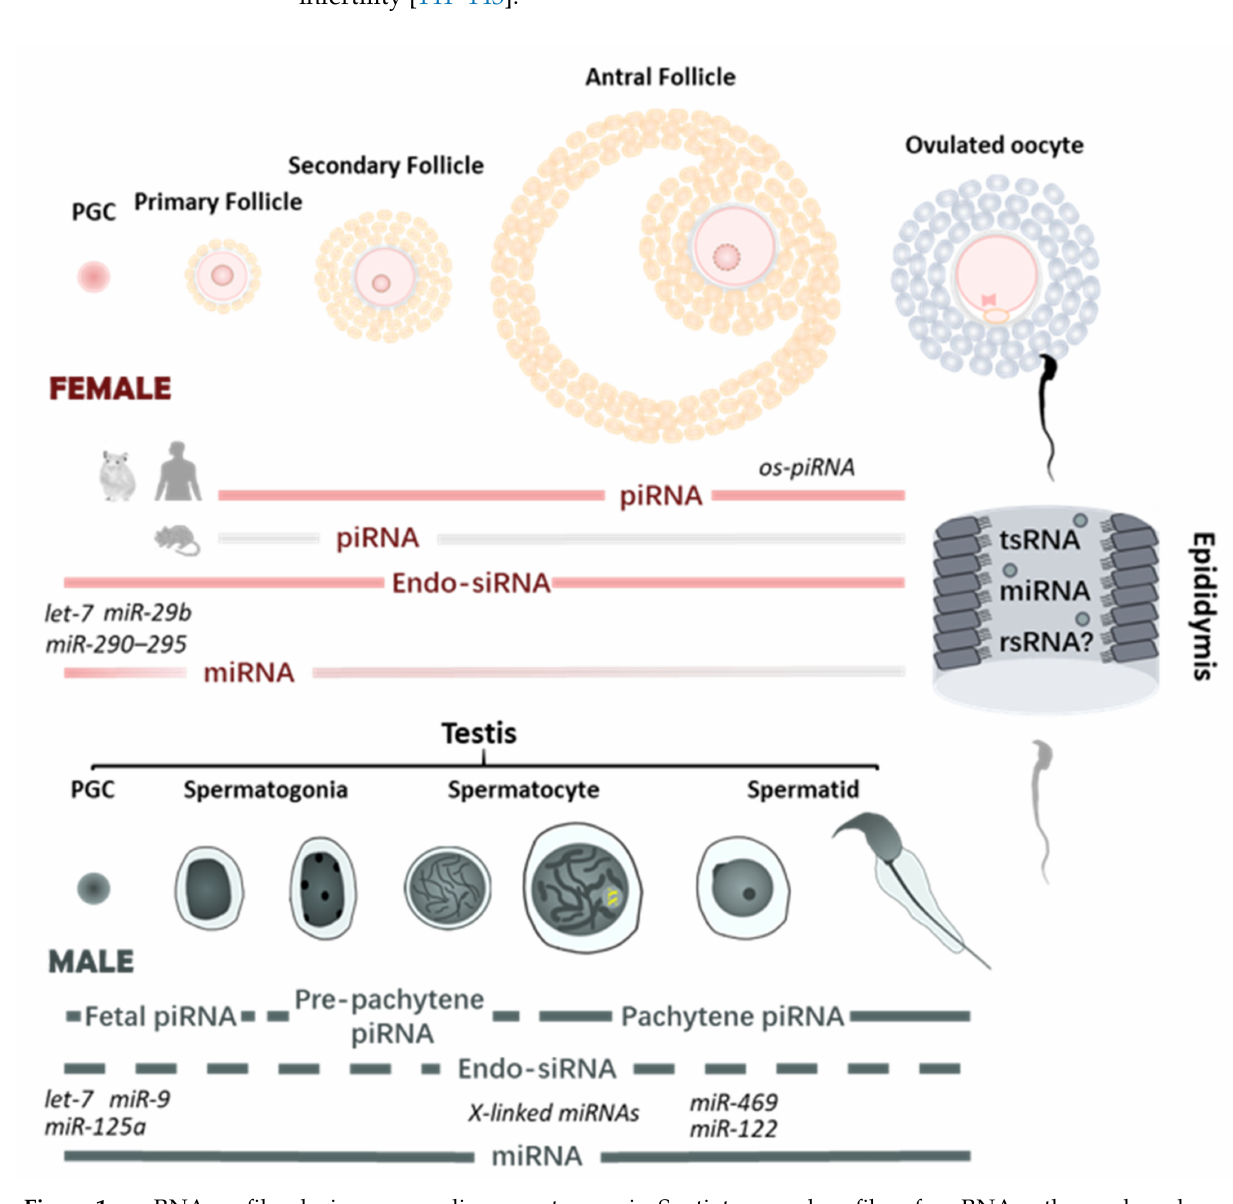
Figure 1. sncRNA profiles during mammalian gametogenesis. Spatiotemporal profiles of sncRNA pathways have been investigated during mammalian germ cell development. In male, piRNAs and miRNAs are essential to spermatogenesis and spermiogenesis. Endo-siRNA pathway is observed during spermatogenesis, yet its function remains largely unknown (shown as dashed line). Spermatozoa also gain sncRNAs during their transit through the epididymis. In female, only endo-siRNAs and potentially noncanonical miRNAs are crucial for mouse oogenesis. As knockout of key components of piRNA and canonical miRNA pathways does not affect female fertility, the activities of those pathways are suggested to be suppressed during mouse oogenesis (shown as grey lines). However, recent studies suggest that piRNA pathway is critical for female fertility in golden hamster and potentially primates, with PIWIL3-interacting oocyte short piRNAs (os-piRNAs) detected in those non-rodent mammals, raising the possibility that piRNAs and PIWI genes may also be required for human fertility in